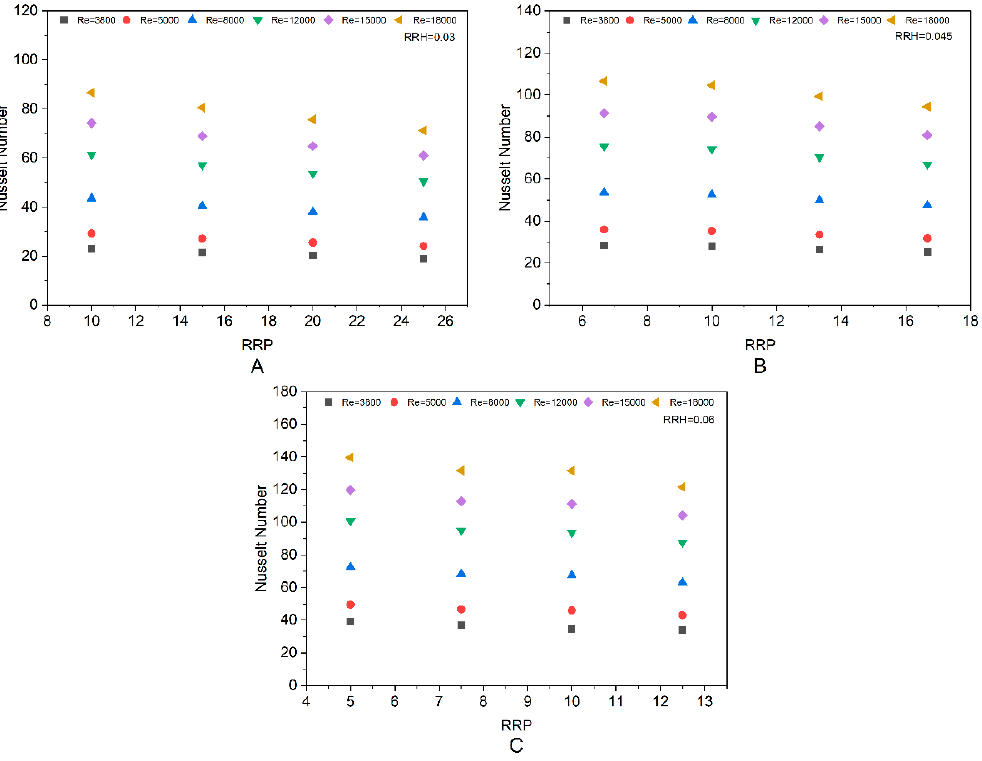
Figure 11. Nu r versus RRP for ( A ) RRH = 0.03, ( B ) RRH = 0.045, and ( C ) RRH = 0.06.